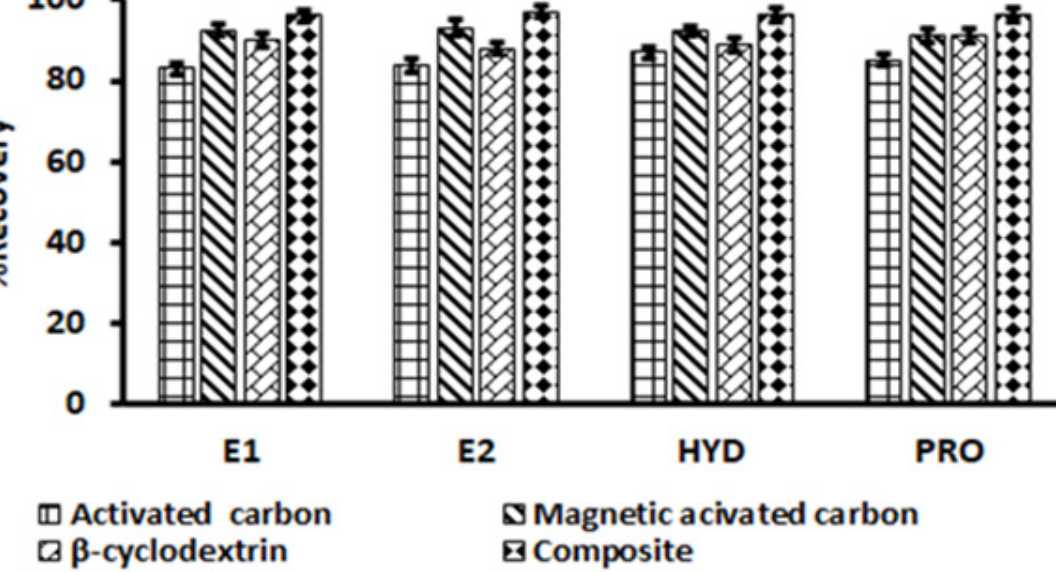
Figure 4. The adsorption performance of activated carbon, magnetic activated carbon, β -cyclodextrin and composite. Experimental conditions: mass of adsorbent (20 mg), extraction time (30 min), eluent volume (1.0 mL), sample pH (6.5), elution time (10 min); sample (5 mL), eluent type (methanol), initial concentration (200 µg L − 1 ).